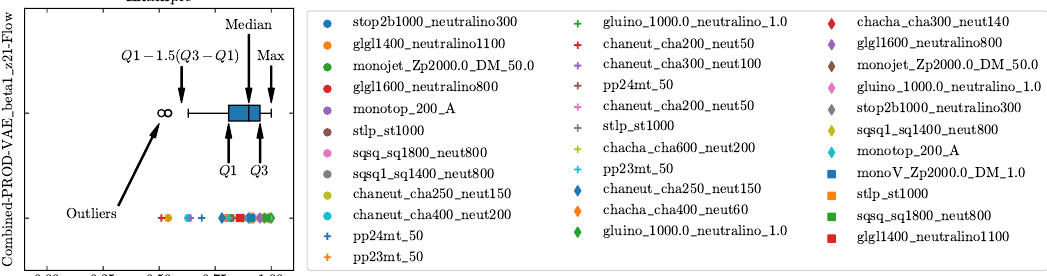
Figure 10: Example of a box-and-whisker plot. The AUC for the Combined-PROD- VAE_beta1_z21-Flow method is marked by the data points for each of the 34 channel- signal combinations. This method uses a combination of flow based likelihoods and a variational autoencoder with a loss function only focused on the KL divergence of the latent space (see Sec. 4.10 for more details). A box is drawn spanning the inner half of the data (Qn denotes the nth quartile), with a line through the box at the median. The whiskers extend to the extremal points unless they are further away from the box than 1.5 times the length of the box. These data points are denoted by